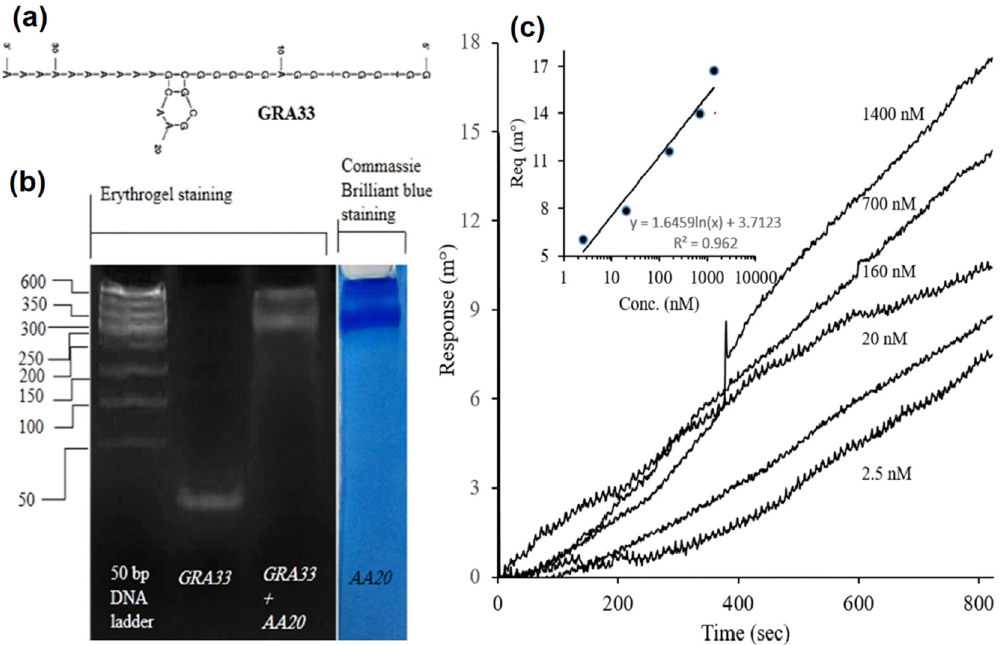
Figure 7. ( a ) DNA sequence of the GRA33 aptamer, ( b ) electrophoretic mobility shift assay results, and ( c ) surface plasmon resonance sensogram results for binding of the GRA33 DNA aptamer with AA20 prefibrillar amyloid aggregates. Adapted with permission from reference [34].